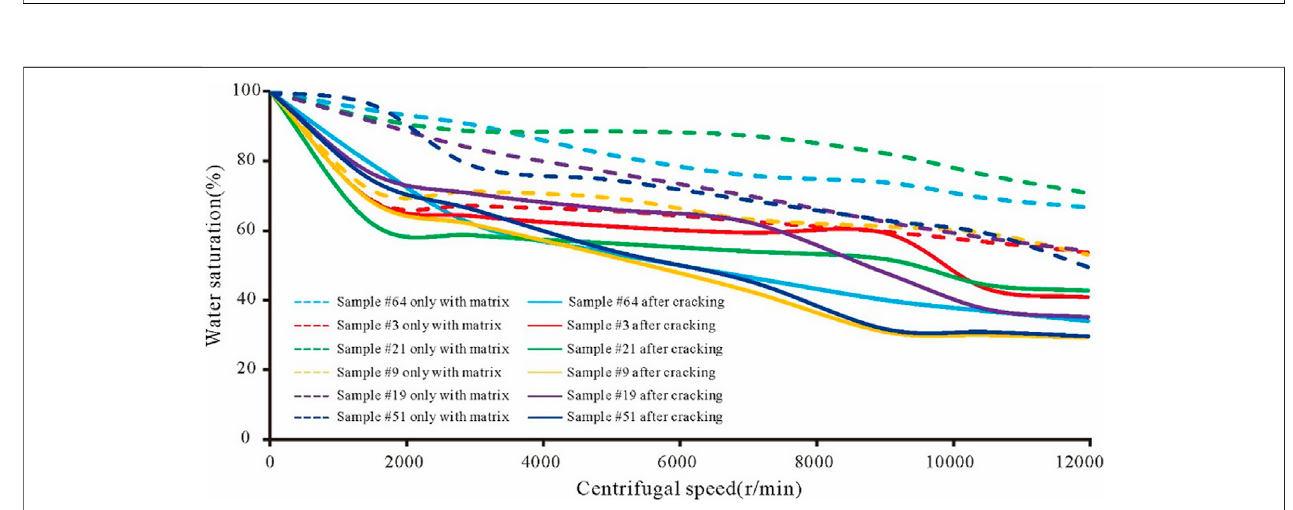
FIGURE 10 | Relationship between centrifugal speeds and water saturation before and after